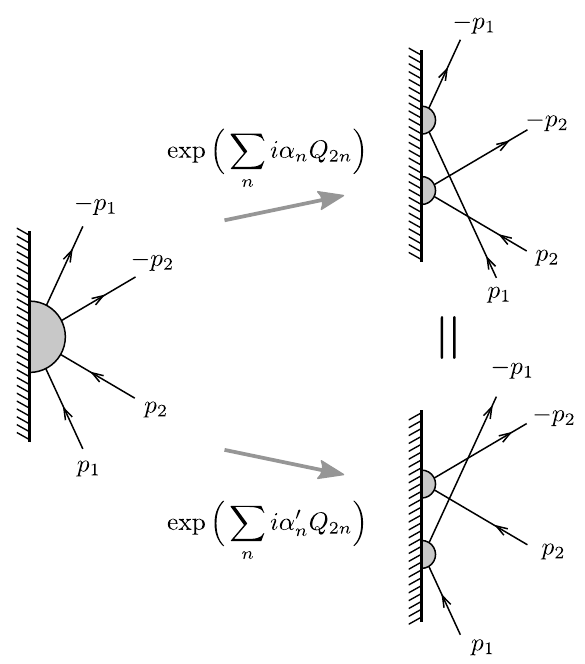
Figure 17 . Conserved charges and the factorized re(cid:13)ection. By acting the higher conserved charges to the re(cid:13)ection process, one can factorize it into one-particle re(cid:13)ection processes. There are two di(cid:11)erent ways of performing the factorization and the equality between the two is the boundary Yang-Baxter